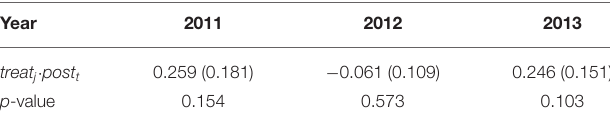
TABLE 6 | Result of robustness test: change of